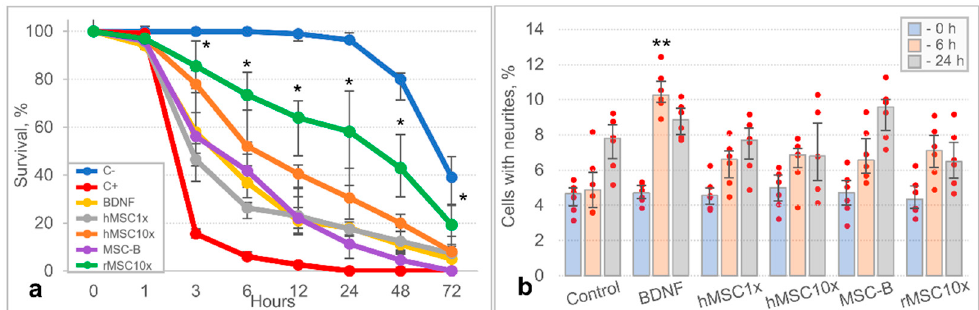
Figure 7. The results of in vitro studies of the neuroprotective activity of MSC secretomes (hMSC1x; MSC-B; hMSC10x; rMSC10x): ( a ) the dynamics of survival of SH-SY5Y neuroblastoma cells under glutamate-induced neurotoxicity conditions [*—H (5,66) < 45.430; p < 0.001 vs control (C+); n = 12; ANOVA on ranks]; ( b ) neurite outgrowth in SH-SY5Y neuroblastoma cell culture [**—H (5,24) = 17.354; p = 0.004 vs control; n = 5; ANOVA on ranks]. Data is presented as a median (25%; 75%).